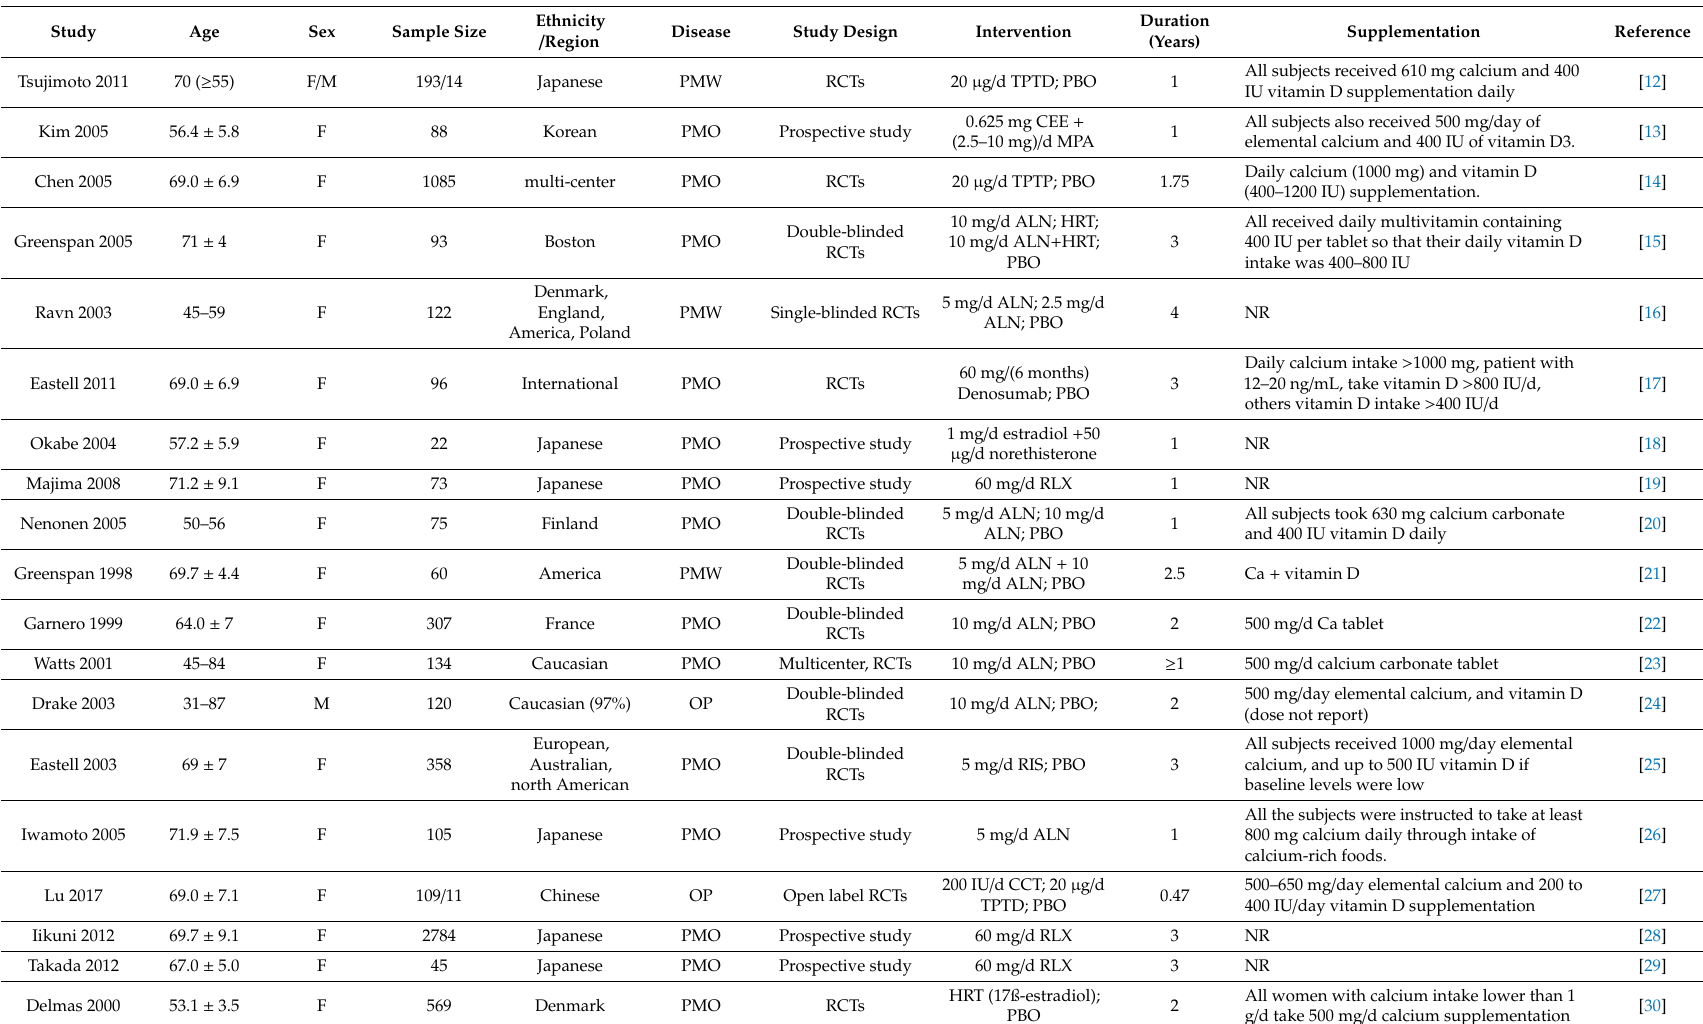
Table 1. Characteristics of the eligible